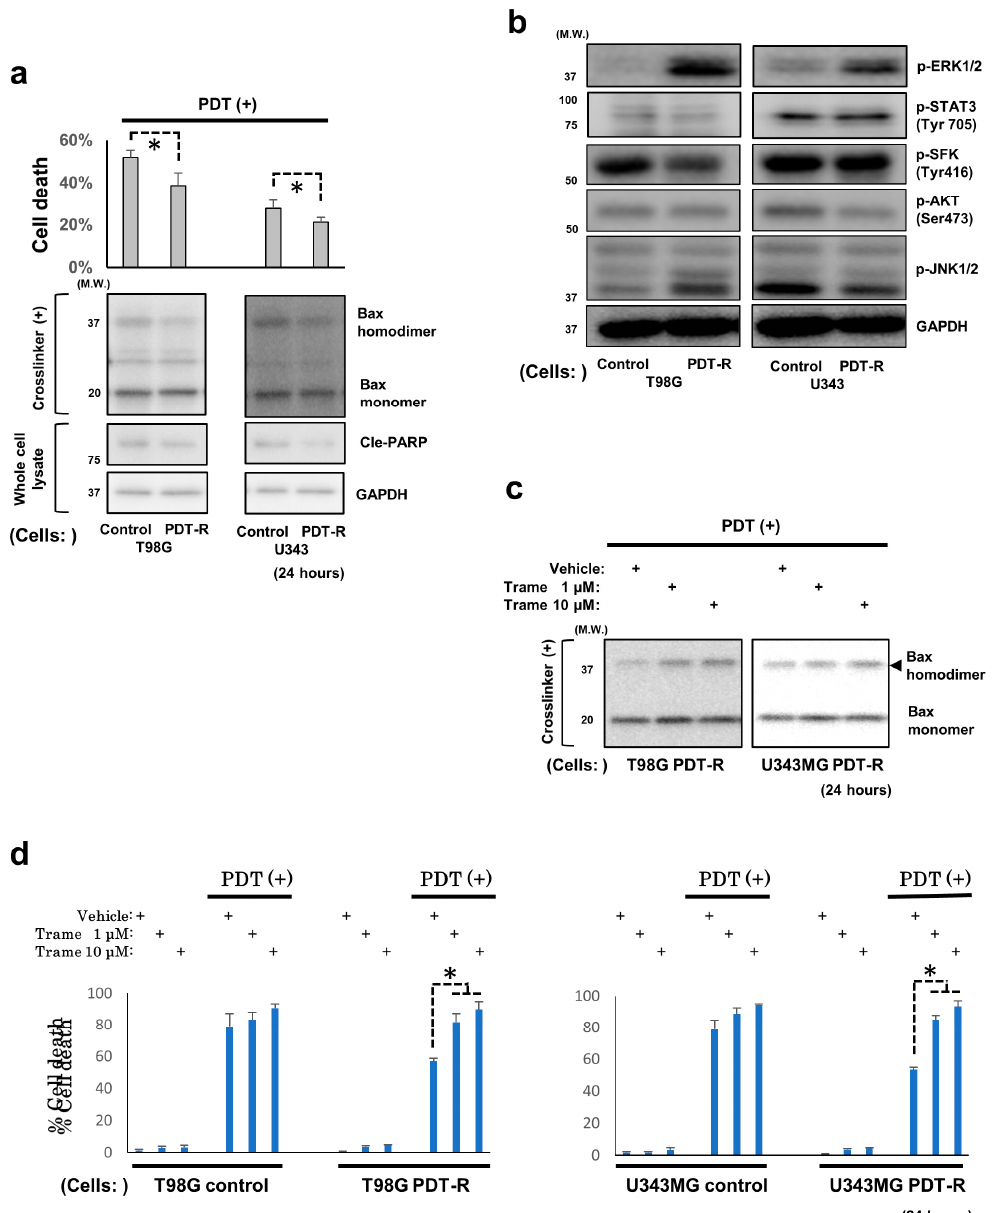
Figure 3. Enhanced extracellular regulated kinase1 / 2 (ERK1 / 2) activation positively regulates the resistance of GBM (NPe6-PDT-R) cells to NPe6-PDT-induced cell death via the suppression of Bax activation. ( a ) Control, as well as NPe6-PDT-R T98G and U343MG cells were subjected to NPe6-PDT (NPe6, 15 μ g·mL − 1 ). After 24 h, the mortality rate of these treated cells was calculated (upper, * p < 0.01). Whole-cell lysates of control cells and equally treated cells subjected to in vitro crosslinking assay were analyzed by immunoblotting using the indicated primary antibodies (lower). ( b ) Lysates of control cells as well as those of NPe6-PDT-R T98G and U343MG cells were analyzed by immunoblotting using the indicated primary antibodies. ( c ) NPe6-PDT-R T98G and U343MG cells were subjected to NPe6-PDT (NPe6, 15 μ g·mL − 1 ), along with treatment with the vehicle or the indicated dose of trametinib. After 24 h, the lysates of crosslinked treated cells were analyzed by immunoblotting using a primary antibody against Bax. ( d ) Control cells, as well as NPe6-PDT-R T98G and U343MG cells were subjected to NPe6-PDT (NPe6, 15 µ g · mL − 1 ) in the presence or absence of pretreatment with the vehicle or the indicated dose of trametinib, as shown in the figure. After 24 h, the cell death rate of all treated cells was determined. * p <